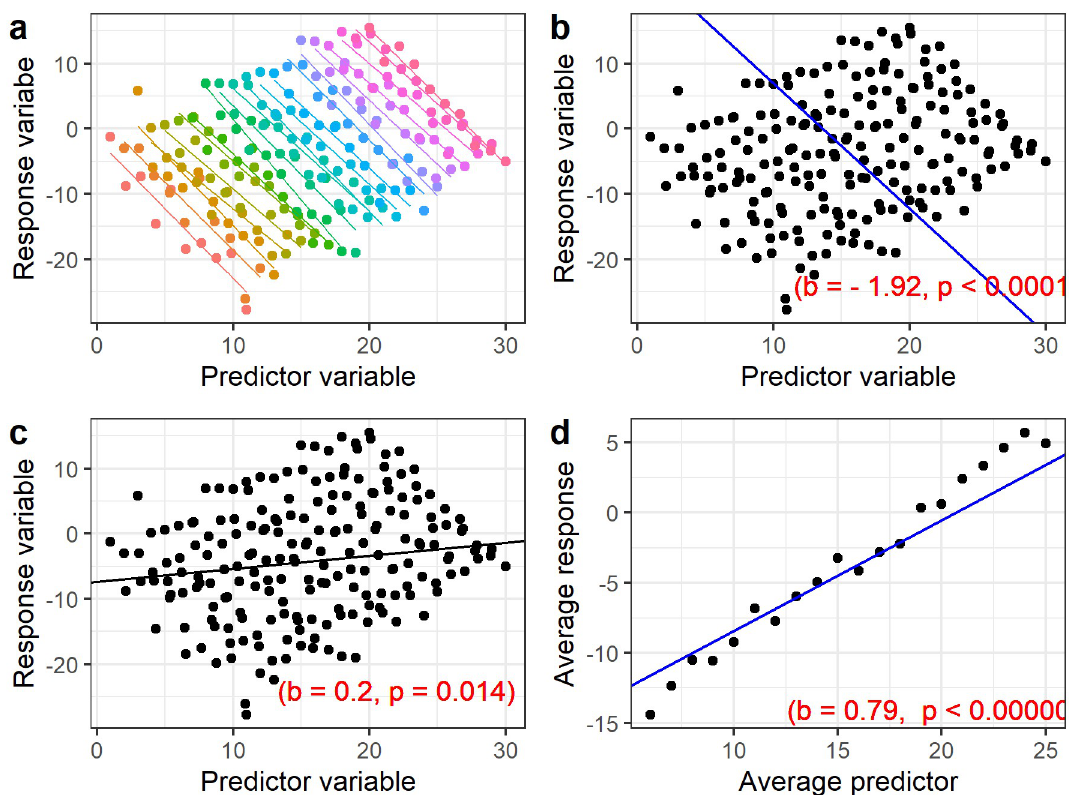
Fig 1. Analyses ignoring and taking into account repeated measures. a) The actual data from 20 individuals (coloured by person), b) Mixed model taking into account subject effects yielding desired results, c) Linear regression model ignoring subject effects leading to inaccurate results with wrong direction of effect and d) Linear regression considering averages per individual giving different direction for the